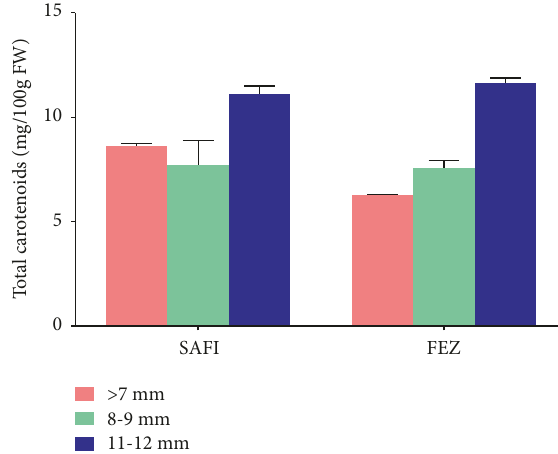
Figure 5: Protein content of three different sizes of Moroccan Capparis spinosa seeds collected from FEZ and SAFI.